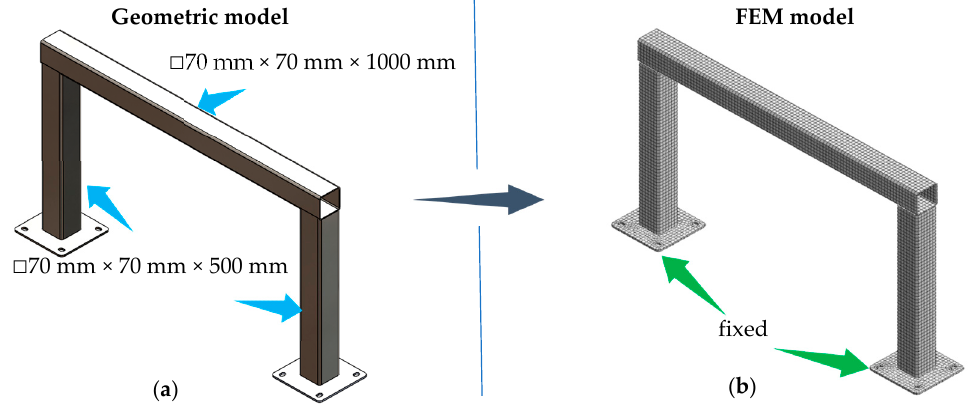
Figure 10. Geometric model ( a ) and discrete model ( b ) of the steel frame under consideration.